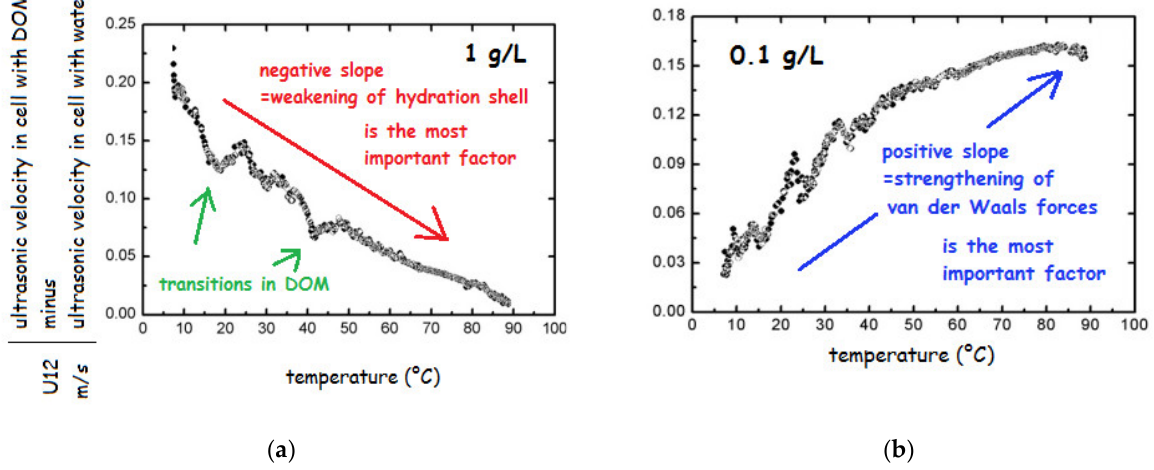
Figure 8. Temperature dependence of ultrasonic velocity of sodium fulvates Suwannee River at concentrations ( a ) 1 and ( b ) 0.1 g/L (based on the results of ref. [69]).